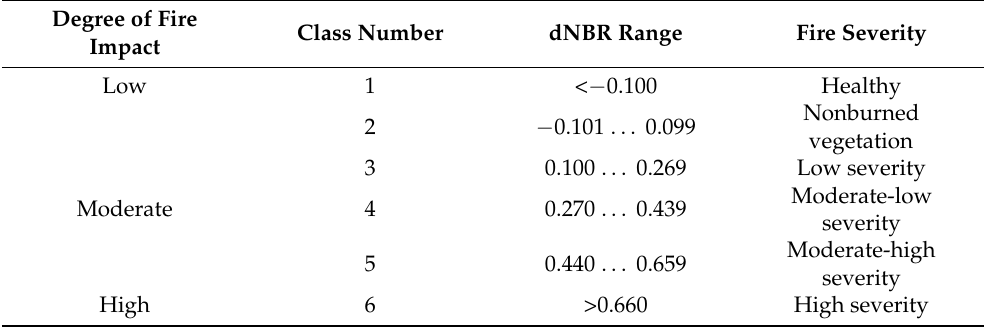
Table 2. Thresholds of the dNBR to classify fire severity and level of fire impact on vegetation cover according to [14,21]. Degree of